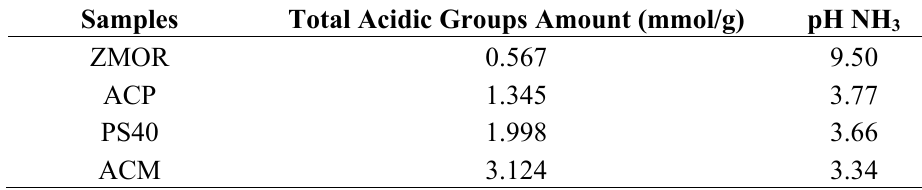
Table 2. Surface pH value and amount of total acidic groups of the samples